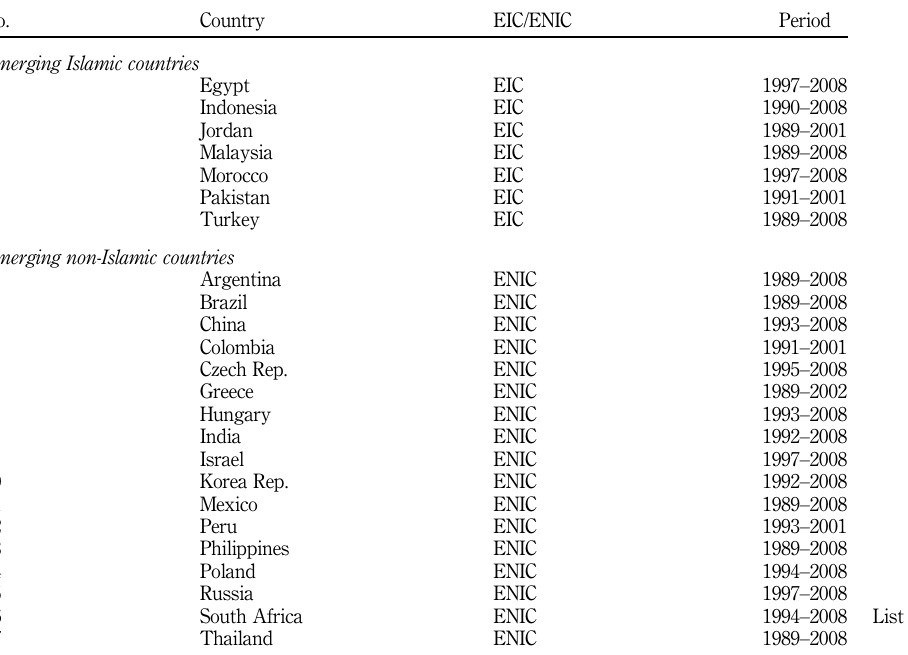
Table AI. List of countries with time